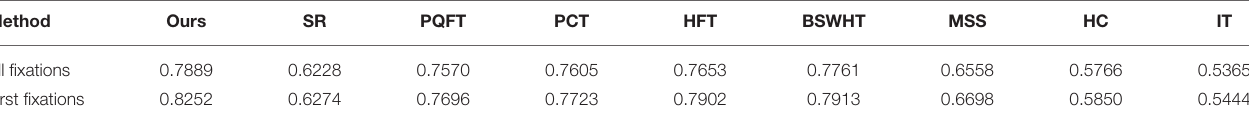
TABLE 1 | The receiver operating characteristic (ROC)- area under the curve (AUC) scores of all nine saliency methods.